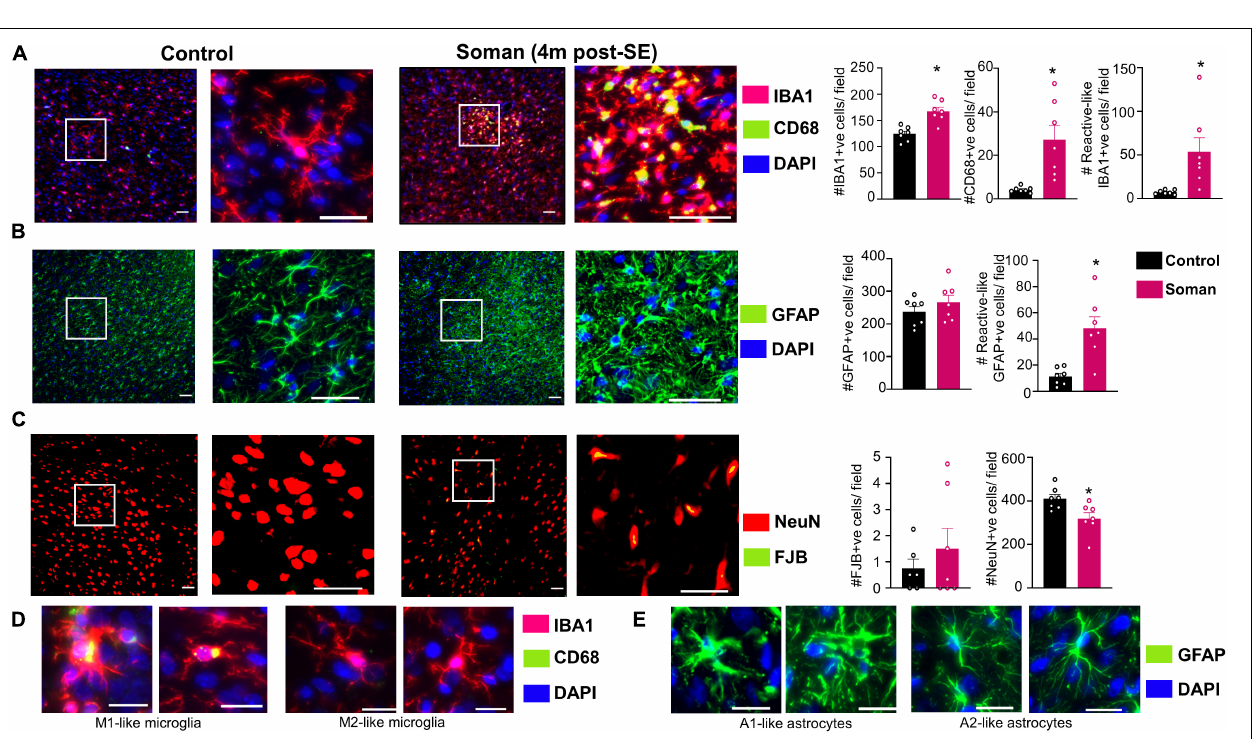
FIGURE 6 | Representative images of amygdala (4 months post-soman) showing (A) reactive microgliosis (IBA1 + CD68, red IBA1 positive microglia, green/yellow CD68), (B) astrogliosis (GFAP, green), and (C) neurodegeneration (FJB + NeuN, green label FJB, red labeled cells NeuN). Examples of reactive and non-reactive astrocytes and microglia are shown in (D,E) . T -test ( n = 7) scale bar, 50 µ m (A,B) , 20 µ m (D,E) ; field = 0.44 µ m 2 . * p < 0.05.